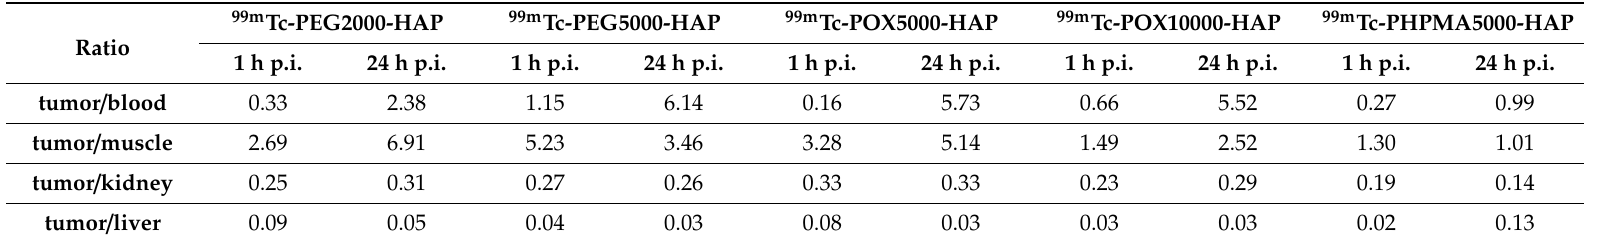
Table 1. Tumor-background and tumor-excretory organs ratios obtained in HT-29 tumor-bearing